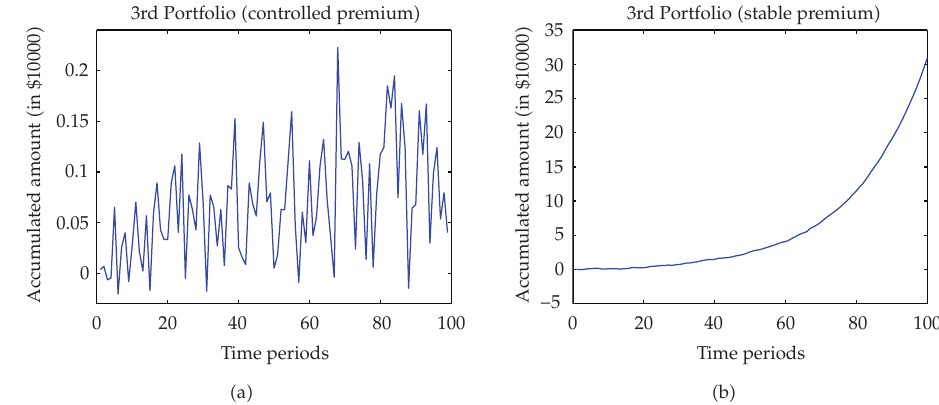
Figure 7: The accumulated profit/loss for (cid:5) stochastic (cid:7) controlled premium and stable premium, respectively, for the 3rd class of a heterogeneous Portfolio for the respective incidents, during 100 unit- time period (cid:5) 300000 simulations (cid:7)